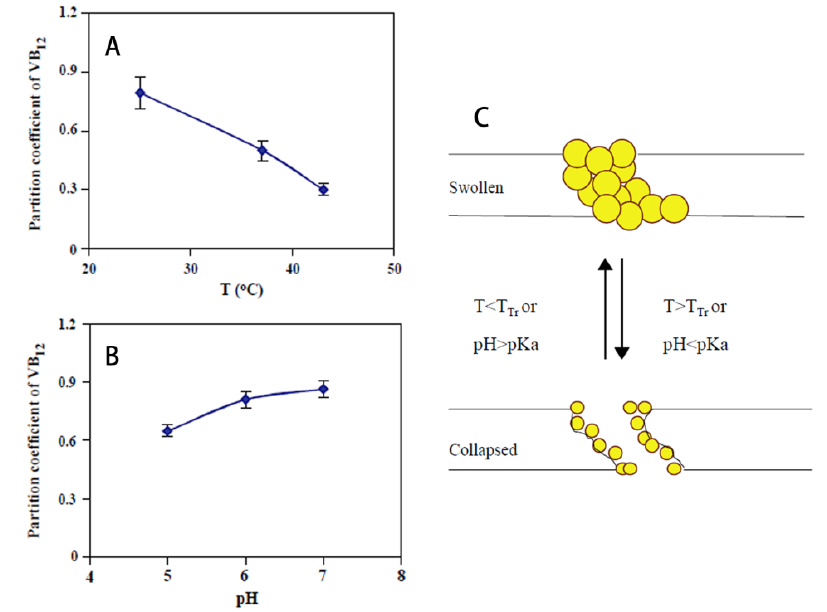
Figure 19. Partition coefficient of vitamin B12 into a composite membrane with 30 wt % of 1:0.4 particles ( A ) In 0.1 mM KCl at varied temperature; ( B ) In 0.15 M PBS with varied pH values at 28 °C; ( C ) Schematic illustration of the permeation model for a composite membrane containing temperature- and pH-responsive nanoparticles. Reprinted with permission from [84]. Copyright 2003